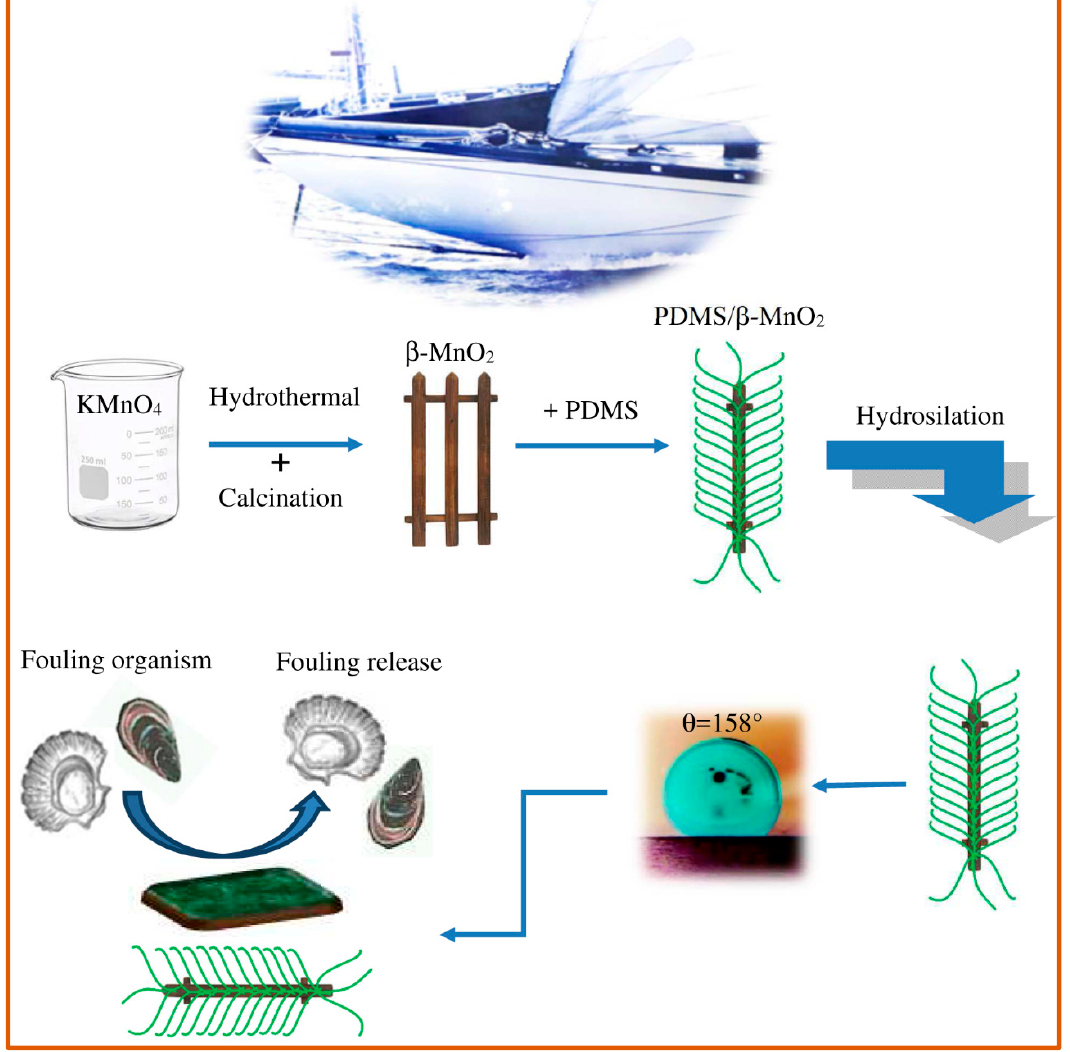
Figure 3. Synthetic route of polydimethylsiloxane (PDMS)/MnO 2 coating with surface rough structure (re-organized from ref. [29]).